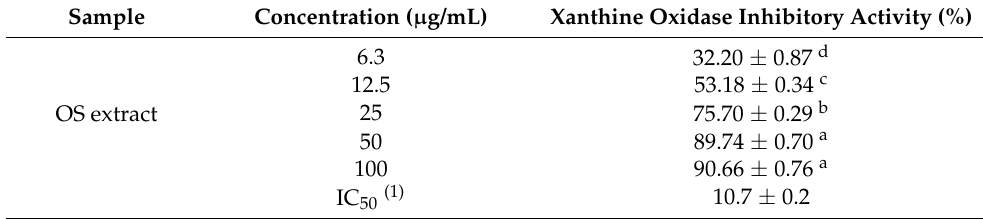
Table 4. Xanthine oxidase inhibitory activity of A. cepa skin (OS)